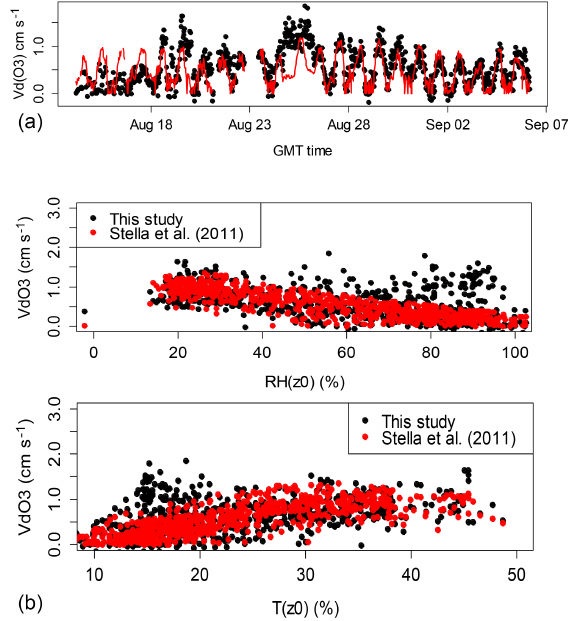
Figure 6. (a) Comparison of ozone deposition velocity from this study (black dots), and from the parameterisation of Stella et al. (2011a) (red line) based on surface temperature. (b) Response of ozone deposition velocity to surface humidity RH( z 0 ) and sur- face temperature T (z 0 ) . Shown are data from this study and from the parameterisation of Stella et al. (2011a). The period covered is from 14 August to 6 September which is before and after slurry spreading and corresponds to Fig.